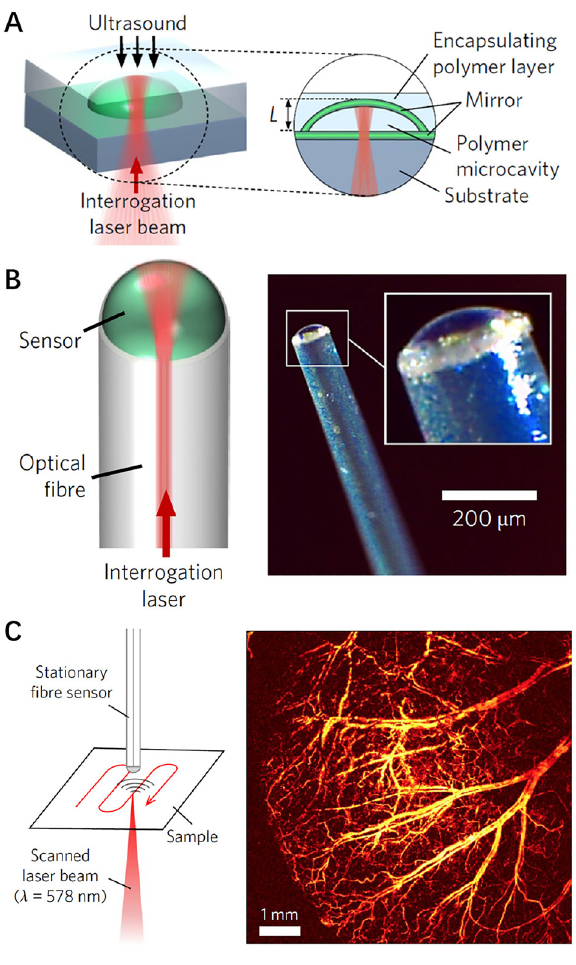
Figure 21: Acoustic sensing using a plano-concave F–P -cavity [59]. (A) Schematic of the plano-concave polymer microresonator.